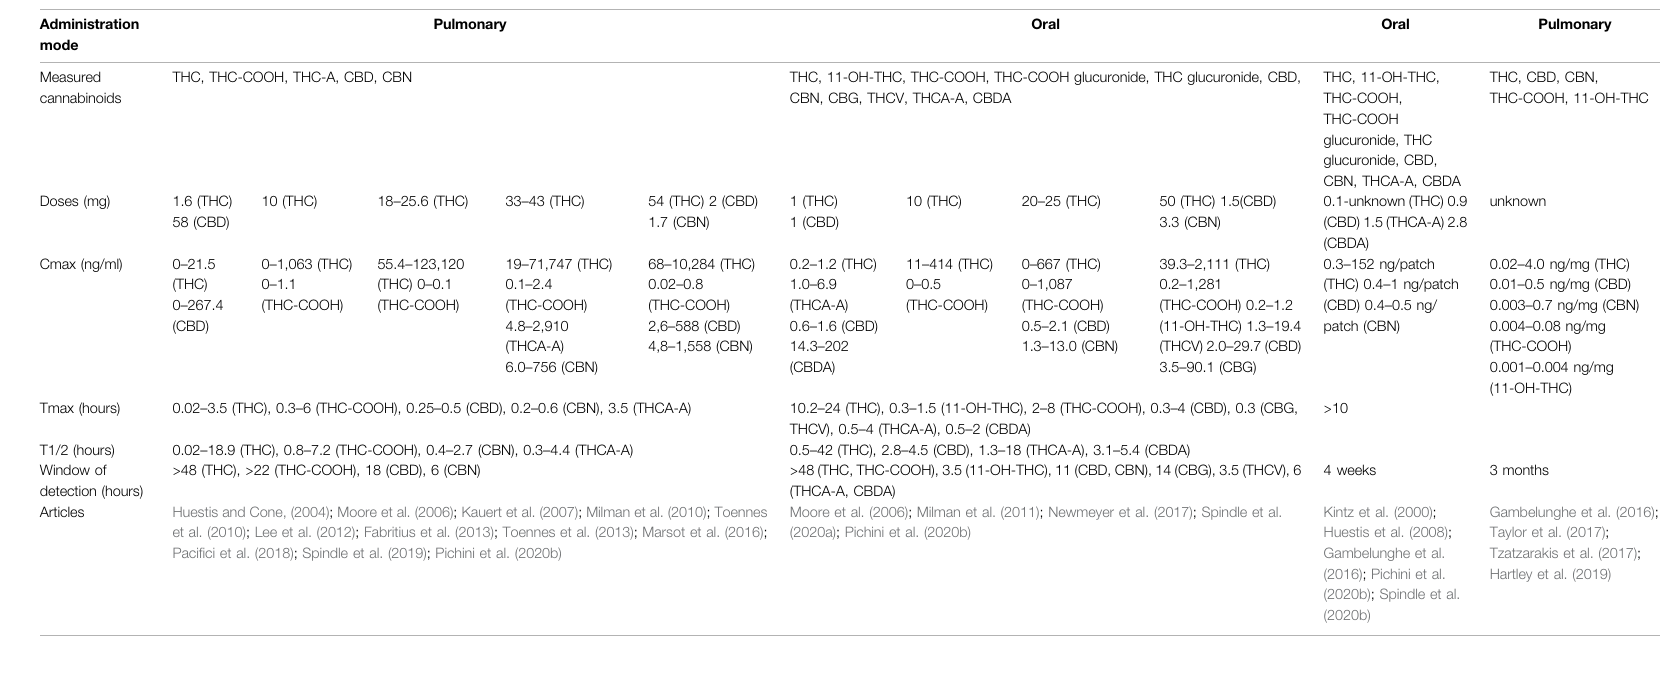
TABLE 1 | ( Continued ) Pharmacokinetics of cannabinoids in the general